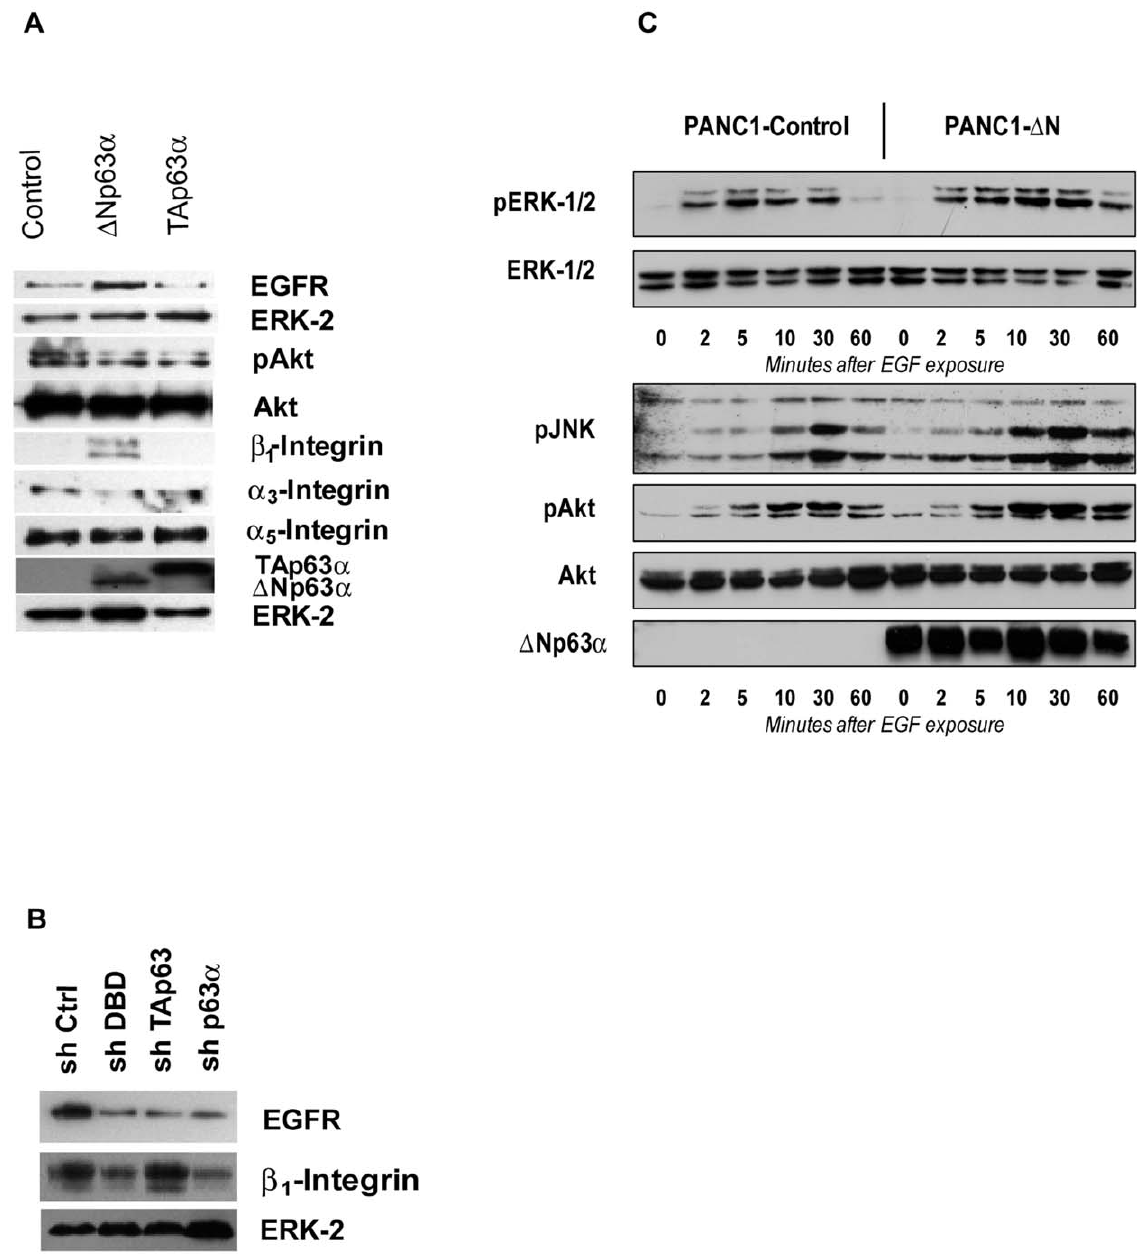
Figure 3. D Np63 a upregulates EGFR expression and signaling in pancreatic cancer cells. A , Ectopic expression of D Np63 a results in increased expression of EGFR and b 1-integrin in PANC-1 cells. After cells were incubated for 48 hours, total protein lysates were subjected to immunoblotting. A representative image of three independent experiments is shown. B , Downregulation of D Np63 a in T3M4 cells results in decreased expression of EGFR and b 1-integrin. A representative image of three independent experiments is shown. C , PANC-1 D N and PANC-1 control cells were stimulated with EGF during indicated time periods. Protein lysates were subjected to immunoblotting. A representative image of three independent experiments is